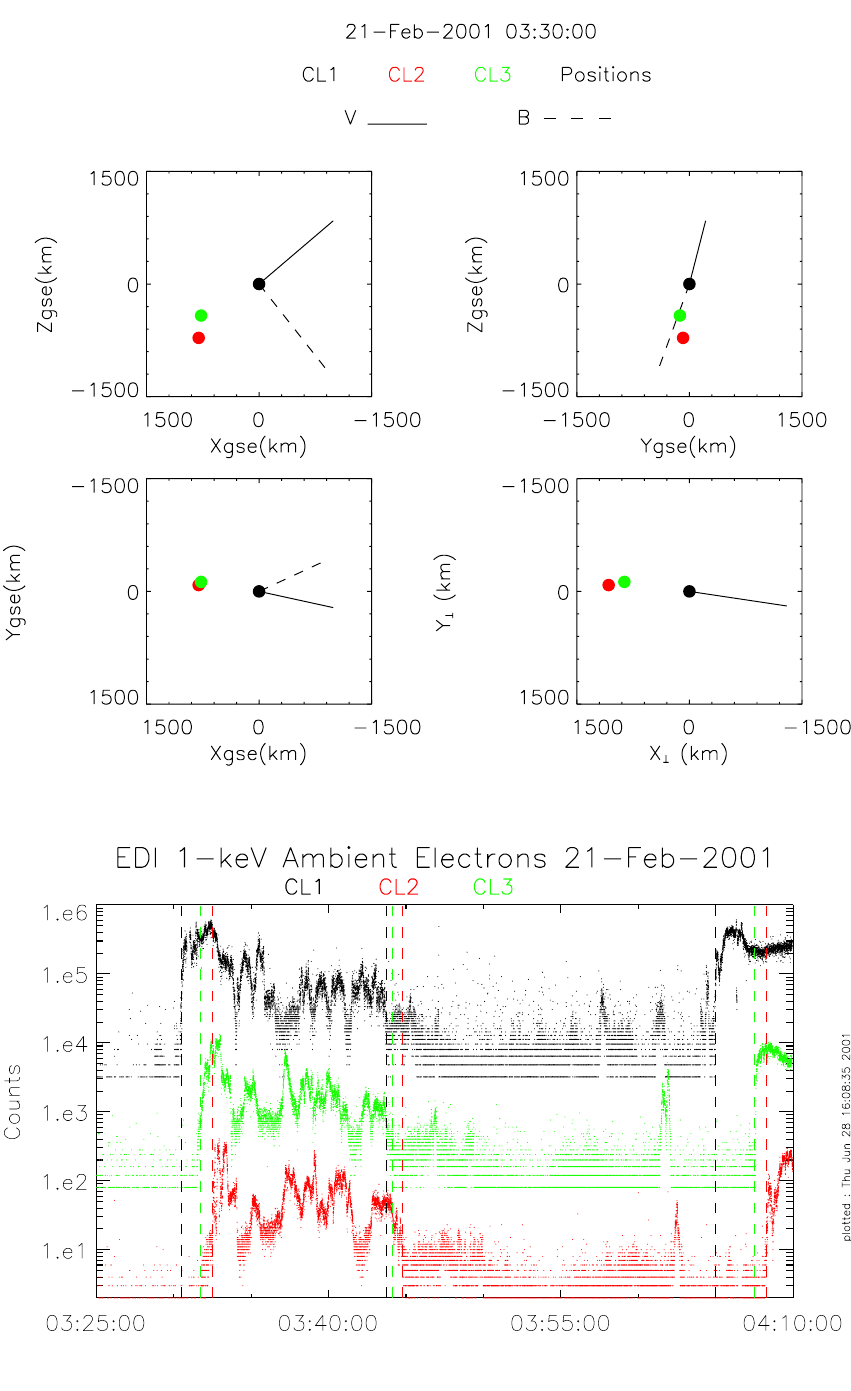
Fig. 11. 1keV ambient electron counts during the 21 February southern hemi- sphere crossing from the polar cap into the auroral zone/plasma sheet, whith the same format as Fig. 7. Counts for spacecraft 1 and 3 are offset by fac- tors of 1600 and 40, respectively. The first region of high counts, from approx- imately 03:30–03:45UT, is a crossing of a spatial structure, as seen by the fact that the three spacecraft enter and exit the feature in the same sequence. Hor- izontal bands near the bottom of each plot represent discrete count levels of 2, 3, 4, etc. Count levels of 0 and 1 have been